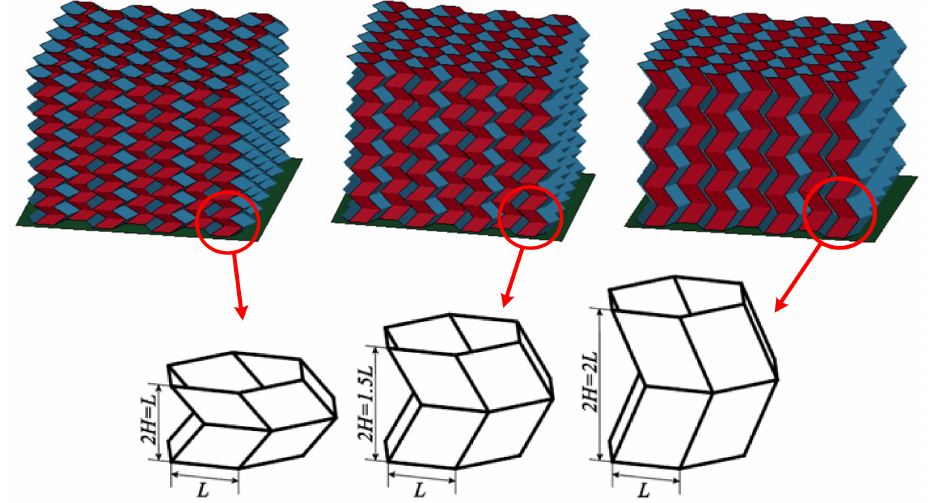
Figure 3. Hexagonal prismatic unit cells of origami honeycomb with different H